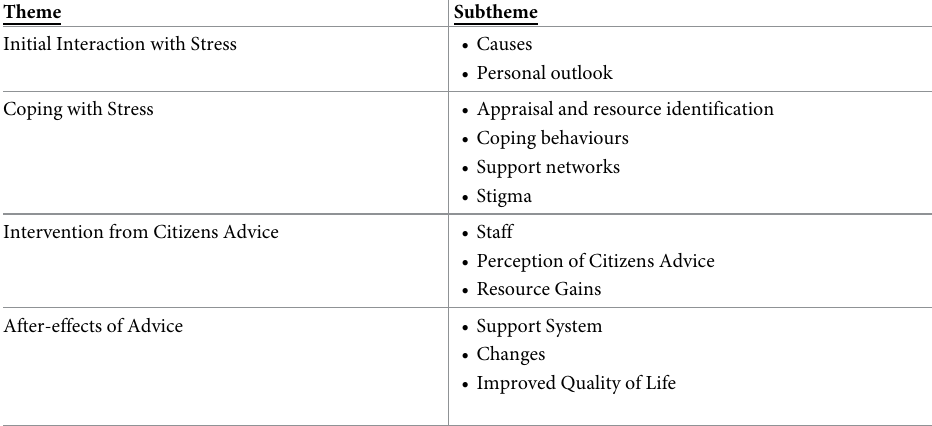
Table 1. List of themes and